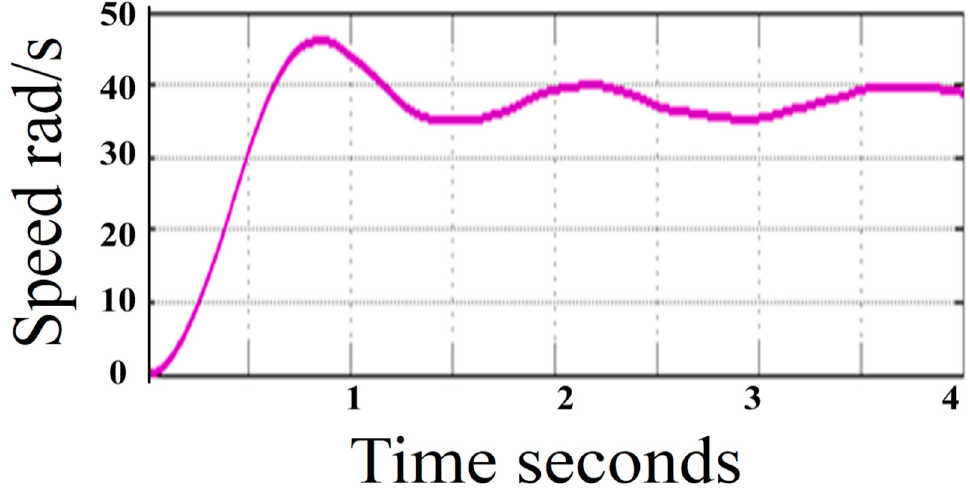
Figure 18. Simulation of the best result obtained in the experimentation with GT2FDE with noise of 0.5 in the FLC.